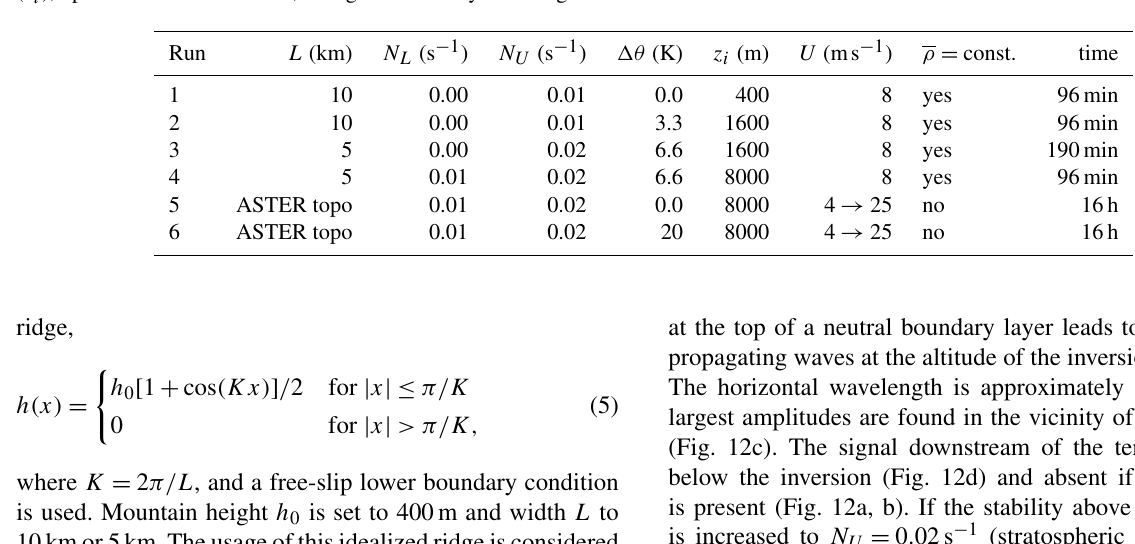
Figure 8. Vertical winds along flight leg RF07 FL2 measured by the DWL and in situ instruments (marked by horizontal red lines) at flight level by the DLR Falcon. Table 1. Mountain width L , static stabilities of the lower and upper layers ( N L , N U ), strength of the inversion ( (cid:49)θ ) and inversion height ( z i ), upstream wind conditions, background density and integration time of the EULAG